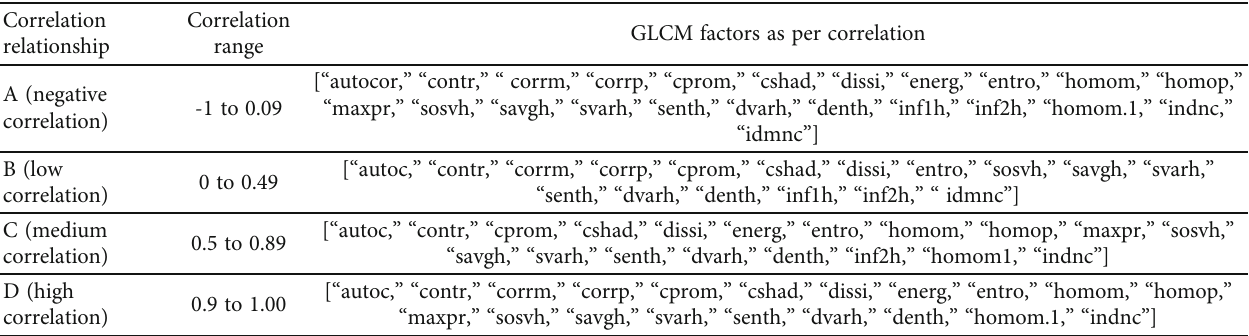
Table 3: Classi fi cation of glcm factors based on correlation